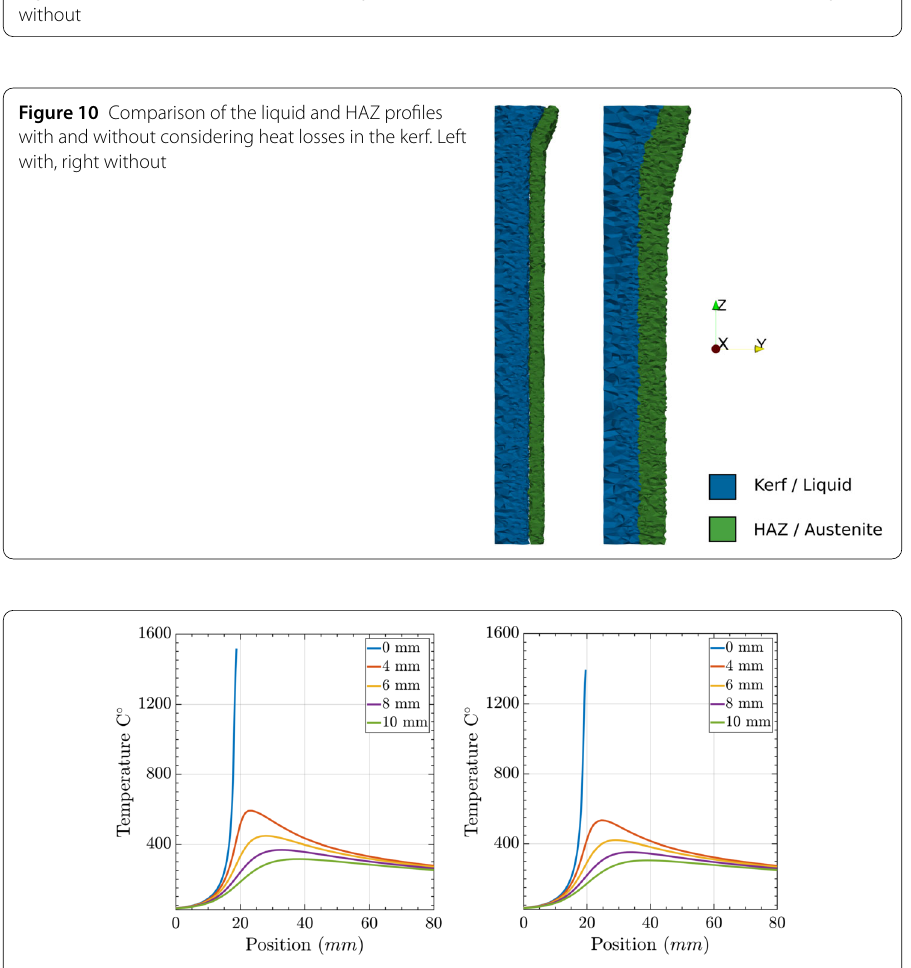
Figure 11 Evolution of nodal temperature from numerical simulation along lines A (left) and C (right). Lines A and C were shifted to distances of 4, 6, 8 and 10 mm from the cutting plane